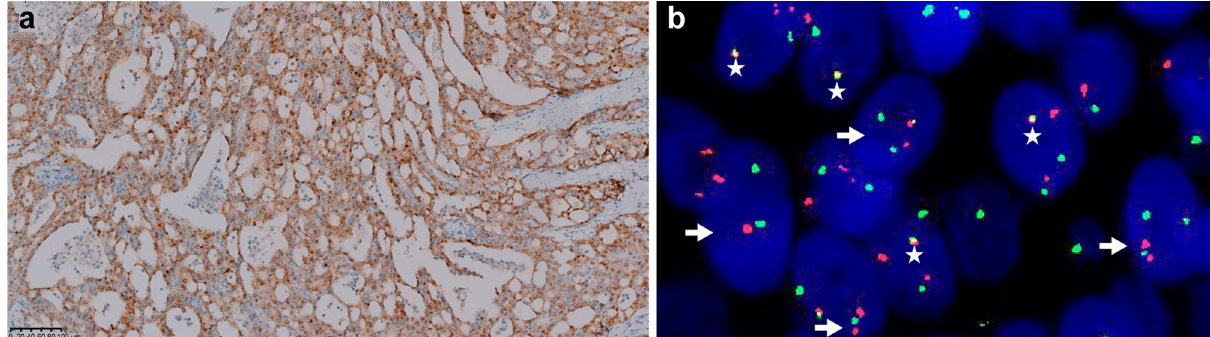
Figure 6. Pan-Trk IHC and FISH of ETV6 . ( a ) Pan-Trk IHC showing nuclear and/or cytoplasmic staining, ( b ) ETV6 gene rearrangement confirmed by fluorescence in situ hybridization as tumor cells with split signals (arrows) adjacent to NTRK3